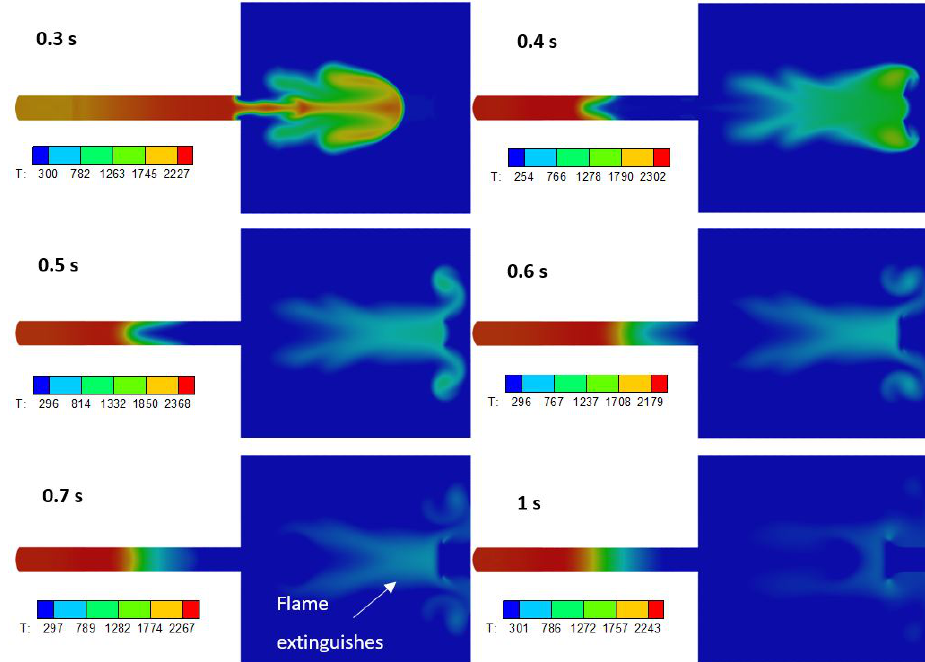
Figure 5. Time series of contour of temperature for the scenario where the VAM methane concentra- tion is 5% and the methane ignition/explosion occurs in